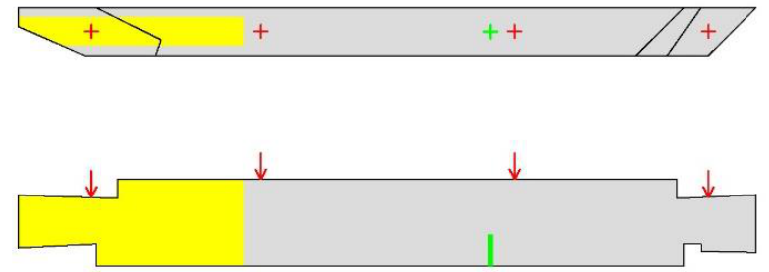
Figure 14. A scheme of the extent of rot, beam (H2) (yellow—replacement, grey—standard wood density without need of repair). Arrow and + marking points measured with Resistograph.